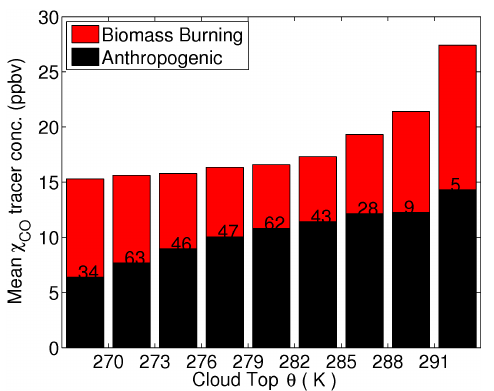
Fig. 7. Mean χ CO concentrations from anthropogenic and biomass burning sources, for clouds below 800hPa, binned by cloud top potential temperatures shown on the bottom axis. Numbers, in thousands, indicate how many FLEXPART grid boxes with liquid clouds, at that potential temperature, were averaged together.